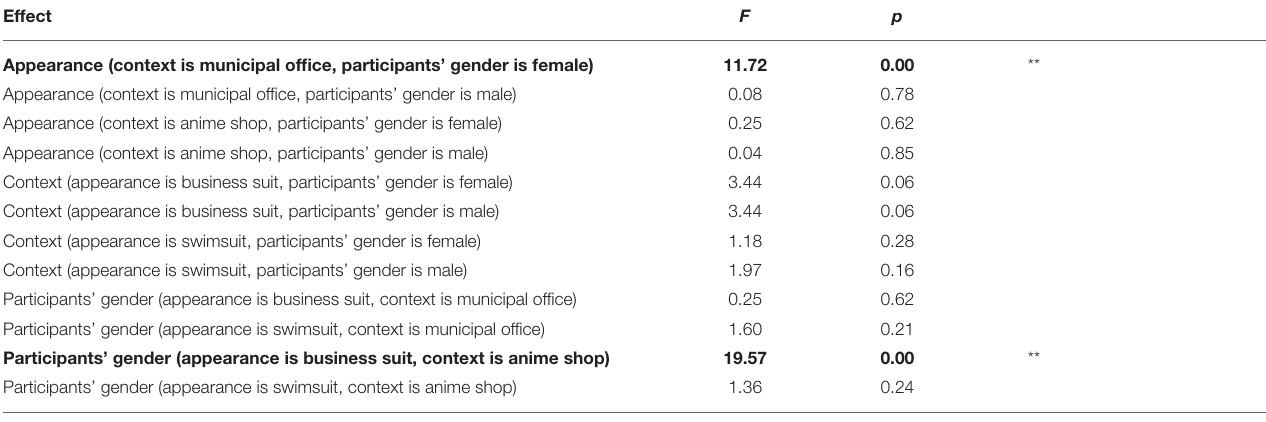
TABLE 8 | Simple main effect test for appearance × context × participants’ gender for Q3 (likability). Effect